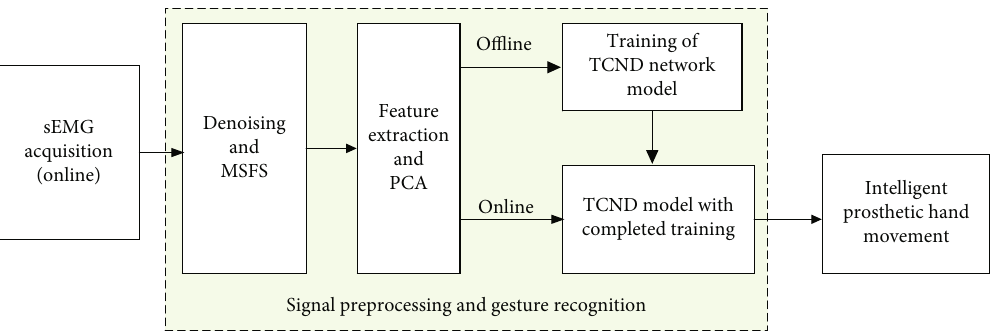
Figure 14: The implementation process of the system.